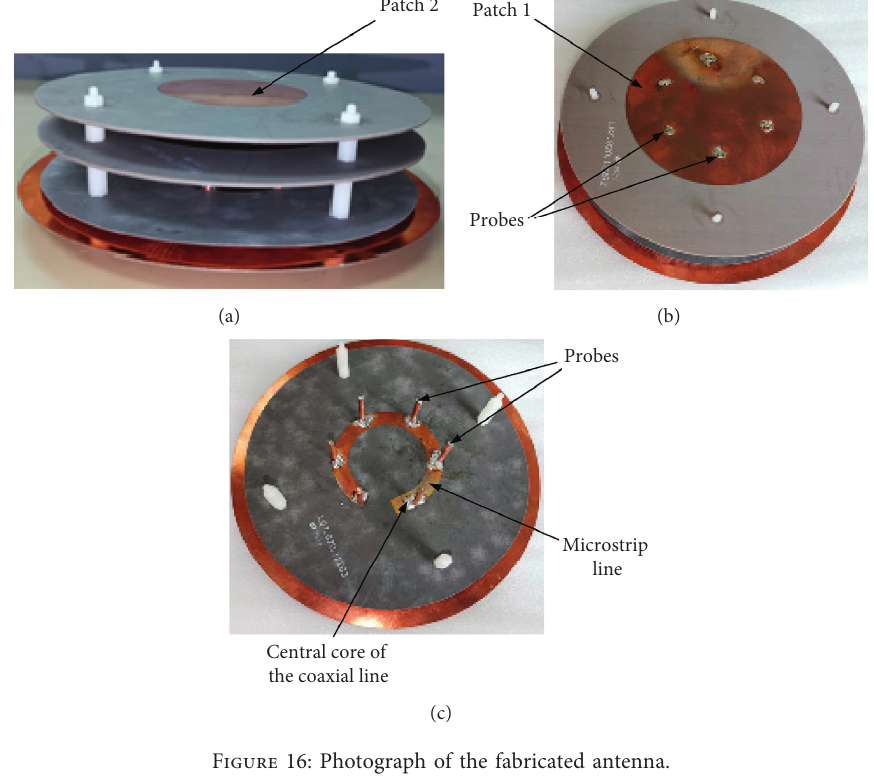
Figure 16: Photograph of the fabricated antenna.